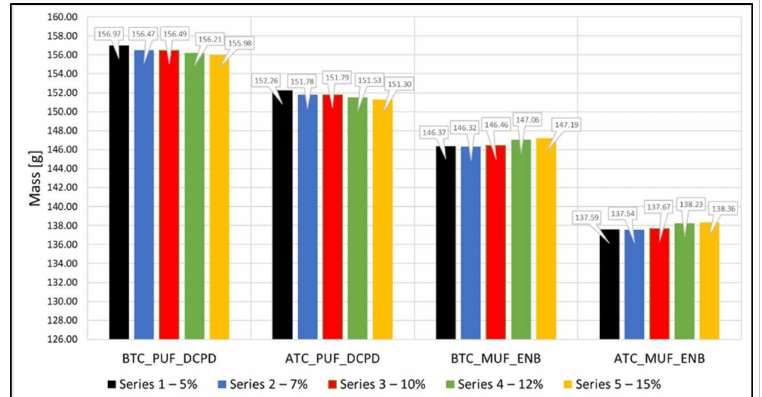
Figure 11. Mass loss after thermal